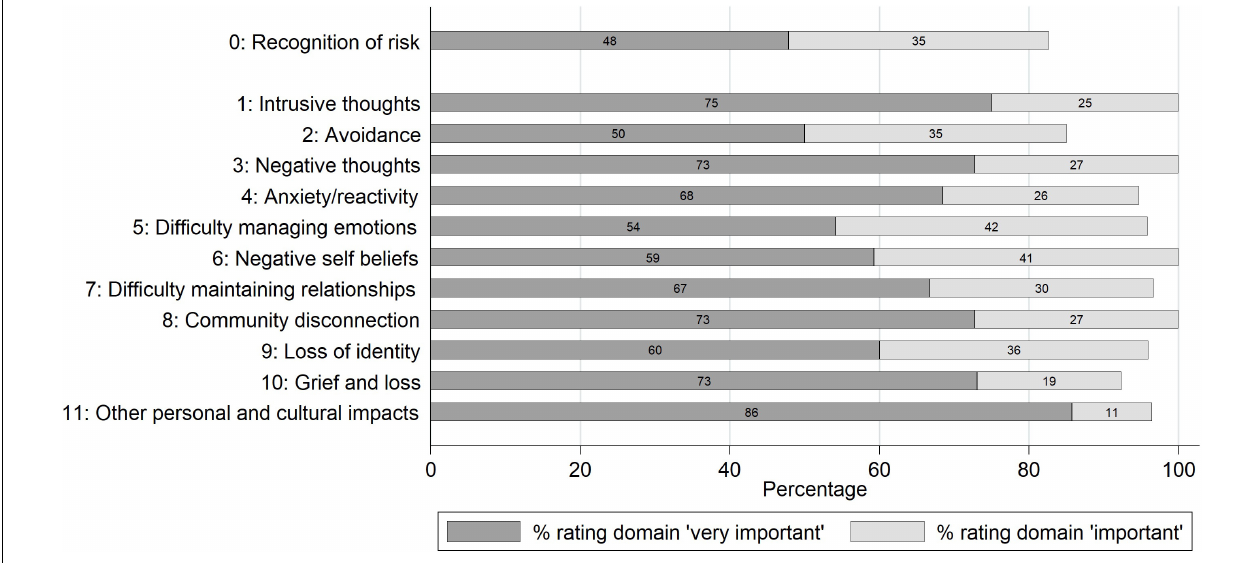
Frontiers in Psychology |